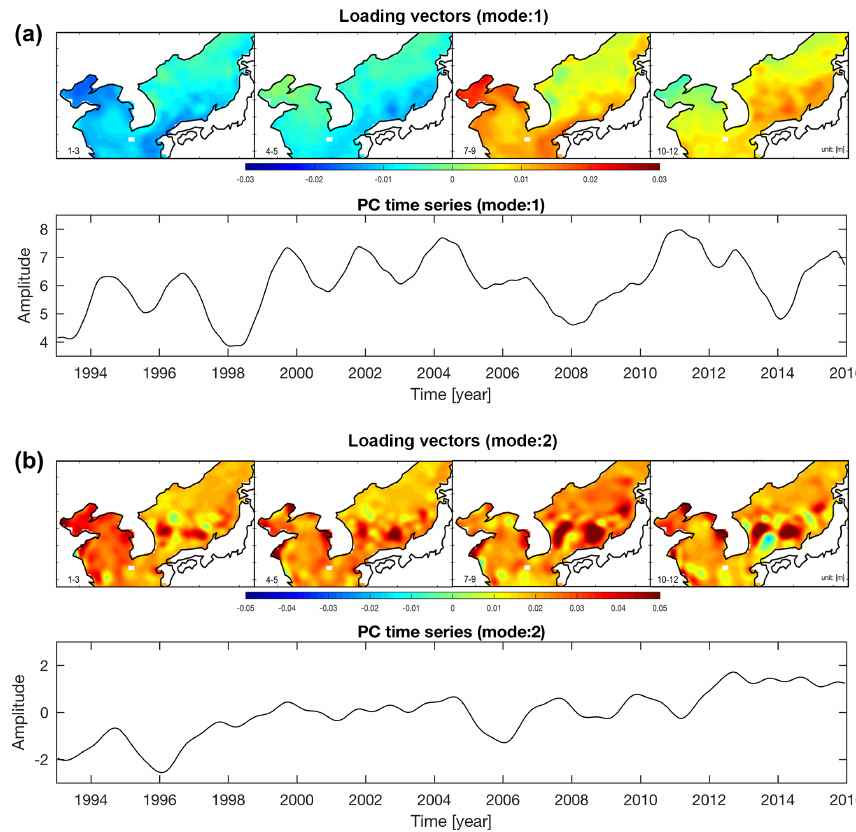
Figure 6. The first (a) and second (b) CSEOF modes of AVISO around the Korean Peninsula.